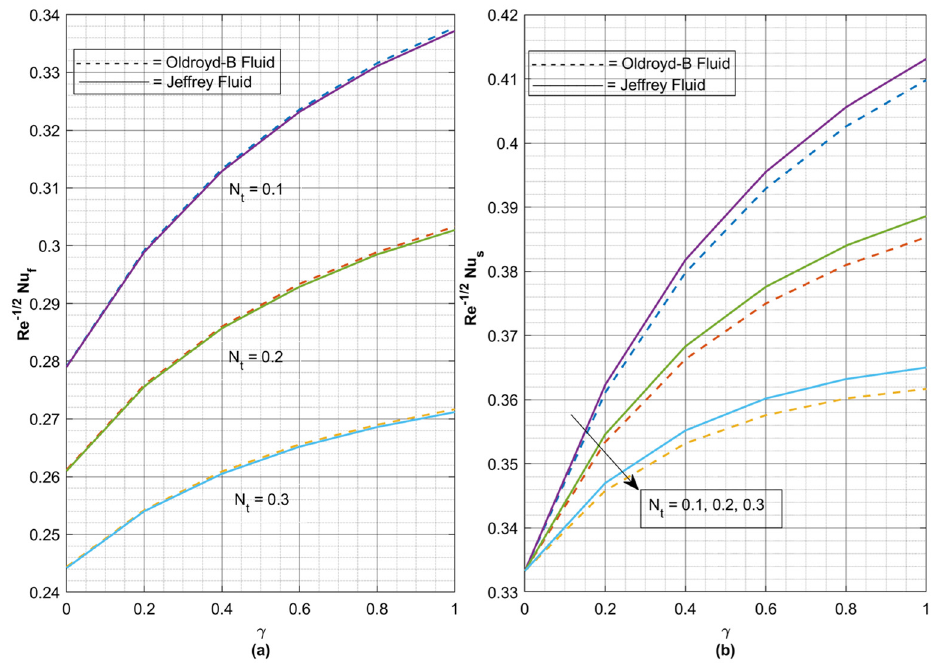
N γ and N γ and